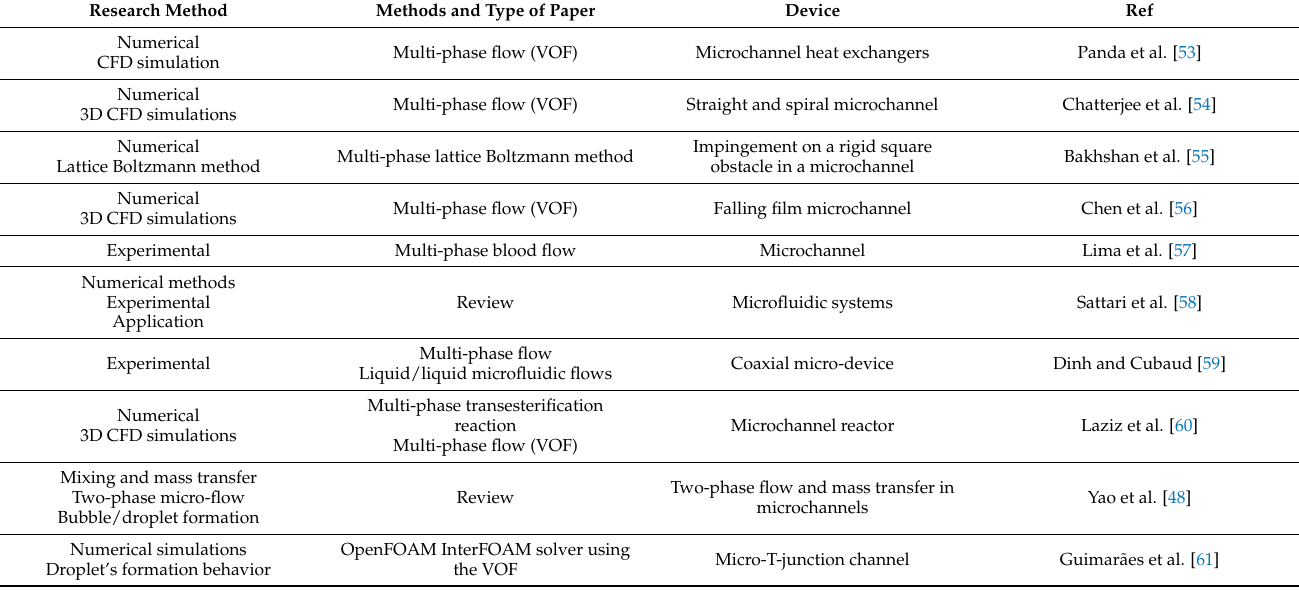
Figure 1. Different applications of MCHs. Table 1. Some research on multi-phase flow in